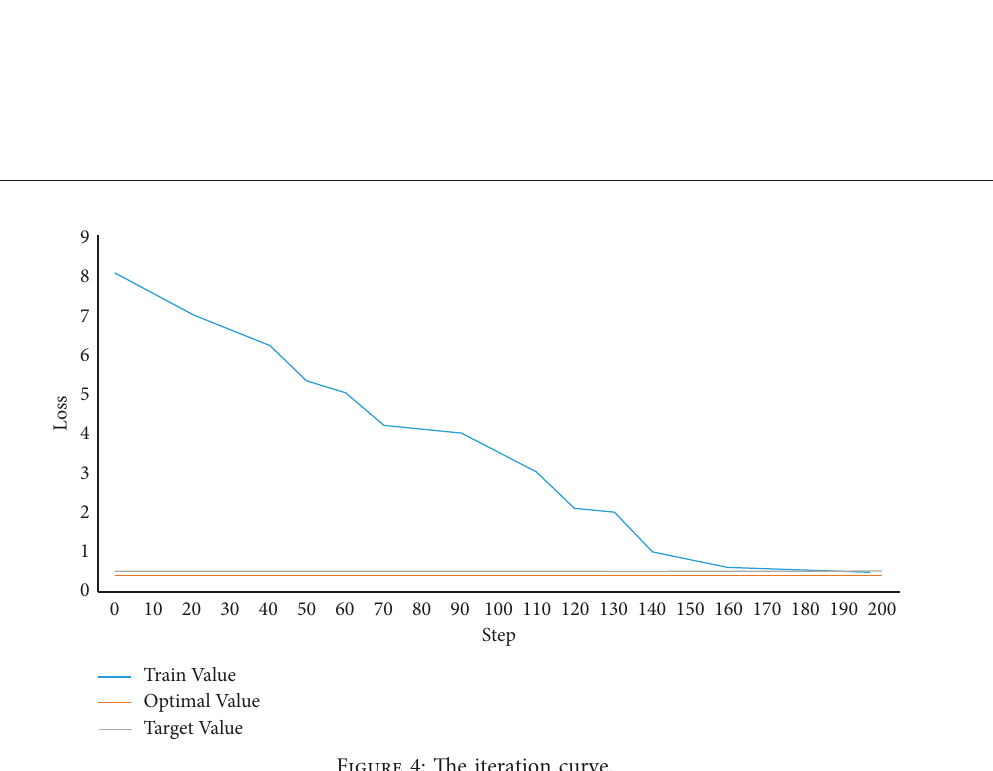
Figure 4: The iteration